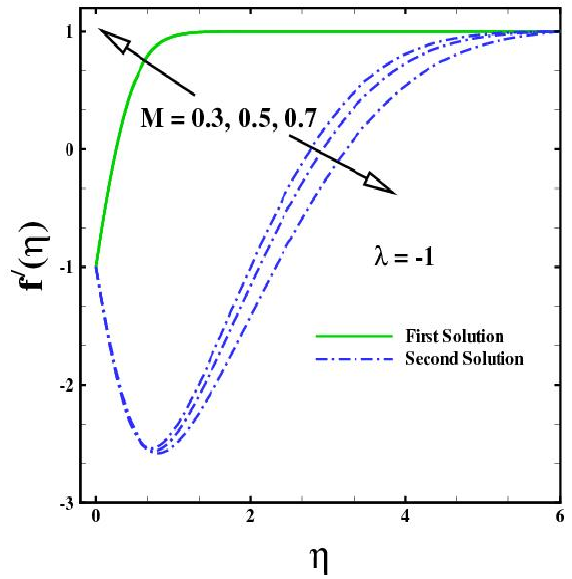
Figure 8. Impact of f ʹ ( η ) with several values of M and We = 0.3, n = 2, Ec = 0.5, Pr = 3, and A = B = β = 0.1.